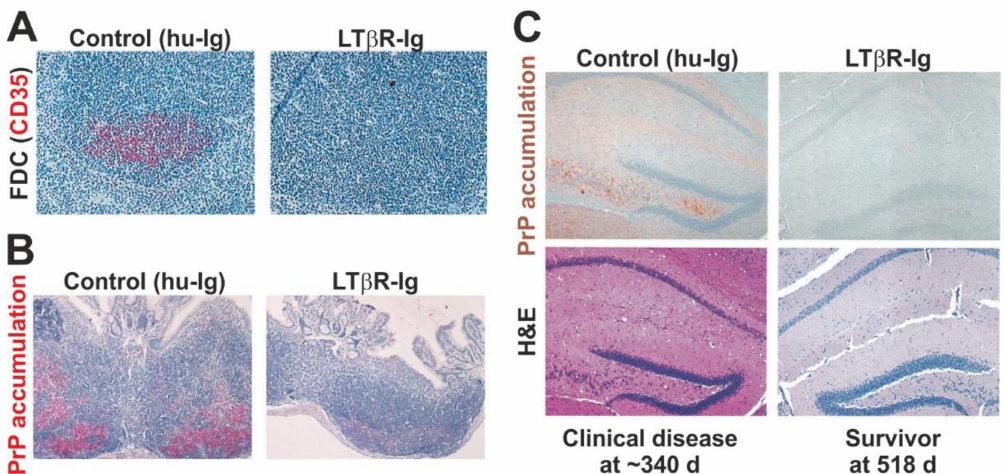
Figure 2. Oral prion disease pathogenesis is impeded in the transient absence of follicular dendritic cells (FDC) at the time of infection [61]. ( A ) Immunohistochemical (IHC) analysis shows that the treatment of mice with a soluble lymphotoxin β receptor (LT β R-Ig) transiently ablates FDC (CD35 + cells, red) insecondarylymphoidtissues. ( B )Prionaccumulation(hereshownasdisease-specificPrPaccumulation by IHC, red) is blocked in Peyer’s patches in the absence of FDC at the time of oral prion infection. ( C ) Oral prion disease susceptibility is blocked in the absence of FDC at the time of oral prion infection. Upper images show IHC detection of disease-specific PrP (brown) and lower H&E-stained panels show presence of prion disease-specific vacuolation (spongiform pathology) in the brains of clinically-a ff ected control mice. All sections counterstained with haematoxylin (blue). Adapted with permission from